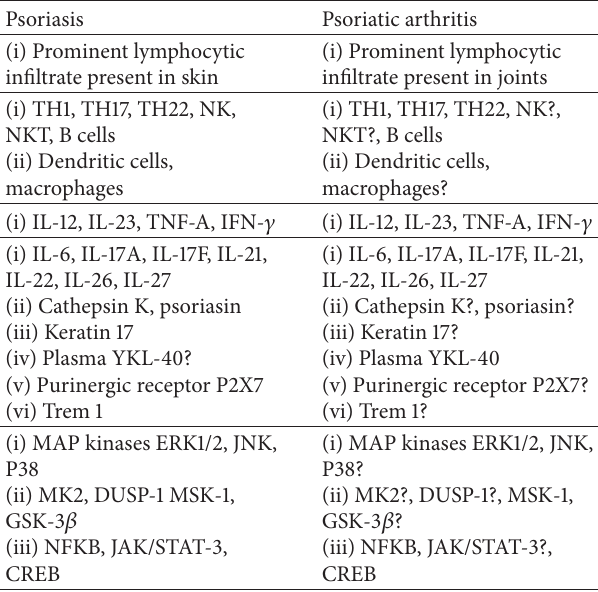
Table 1: Innate and adaptive immunity mediators likely to be involved in psoriasis and psoriatic